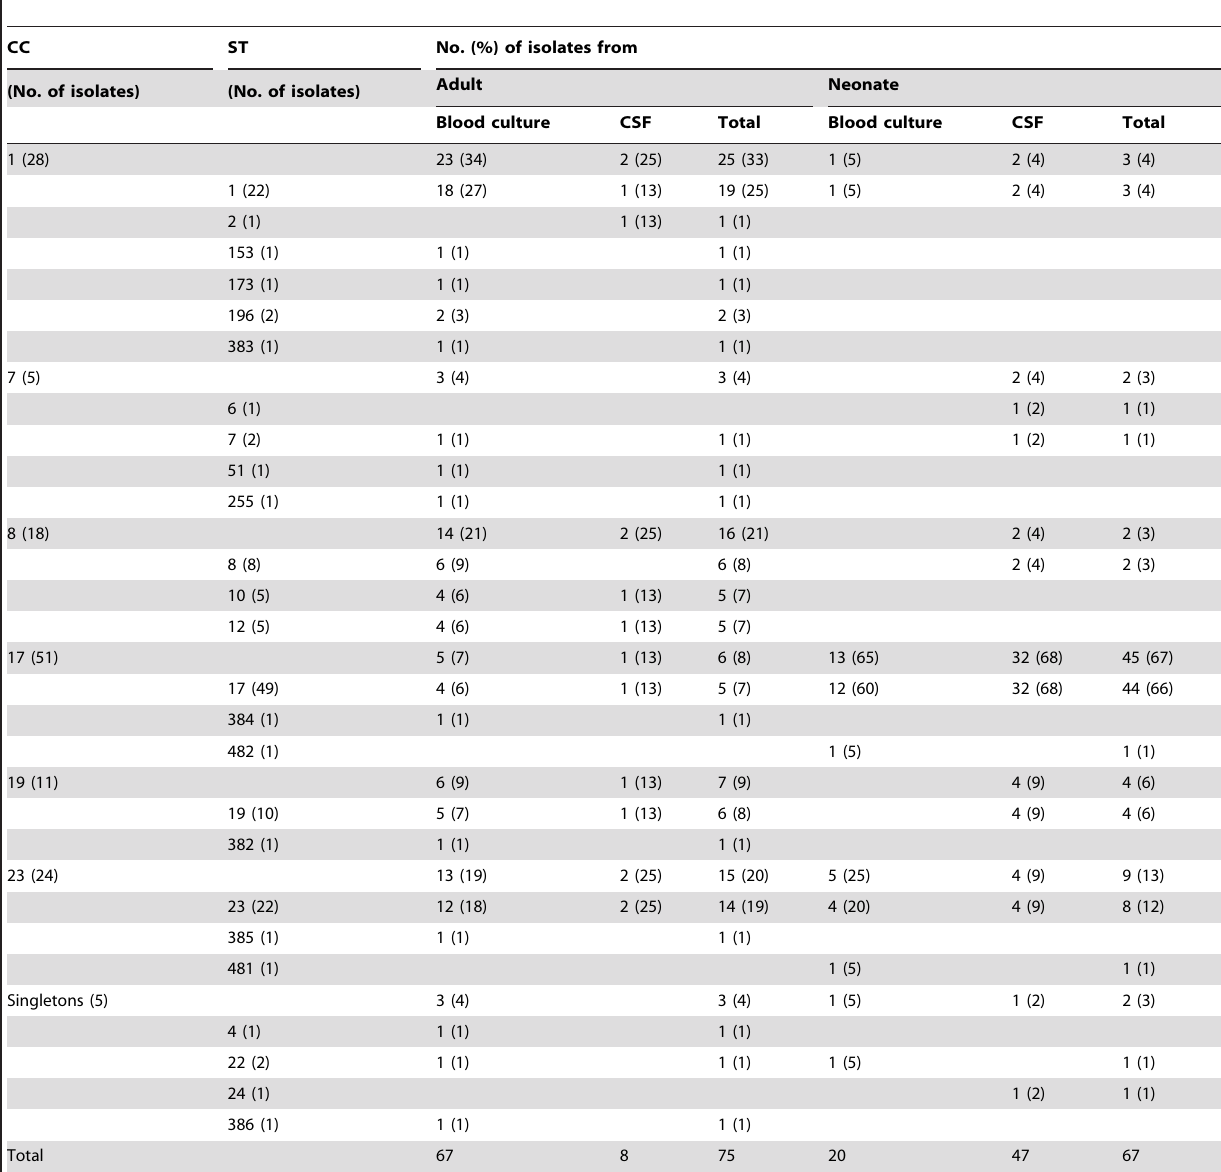
Table 4. CC, ST of S. agalactiae isolates from adult and neonatal invasive infections.